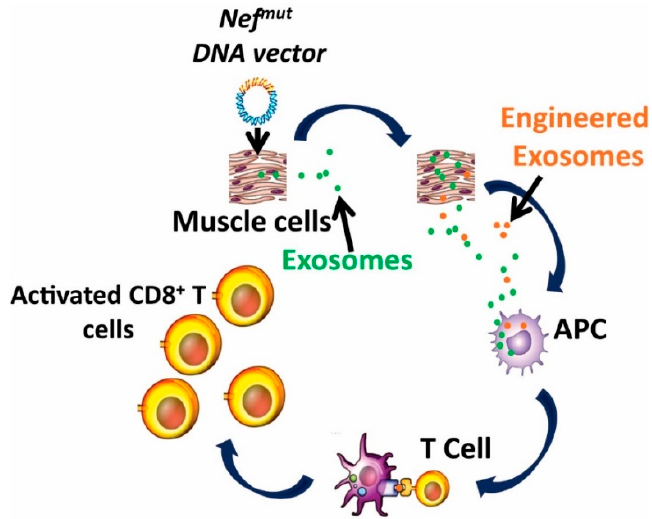
Figure 2. Rationale of the Nef mut -based CTL vaccine platform (concession IJN: December 2017) [77]. APC: antigen-presenting cell.